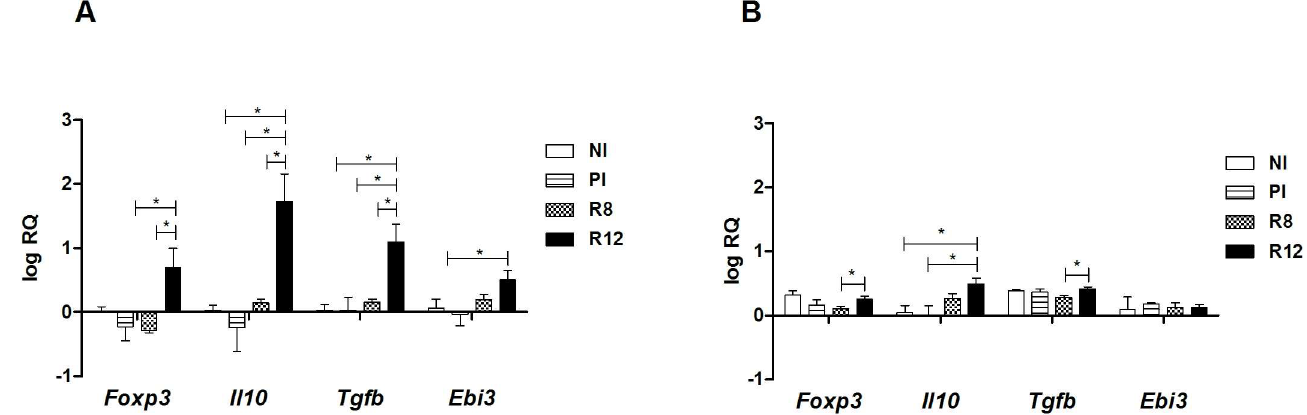
Fig 4. Effect of Fasciola hepatica reinfection on the Foxp3 , Il10 , Tgfb and Ebi3 expression from the spleen and thymus. A) Spleen. B) Thymus. Group NI: non-infected controls; Group PI: rats receiveda single infectiondose; Group R8: infected and reinfected rats at 8 weeks after primary infection; Group R12: infected and reinfected rats at 12 weeks after primary infection. P < 0.05 was considered statistically significant.Bars represent mean ± SE values. * Statistically significant differences (P < 0.05,Mann-Whitney non-parametric test).